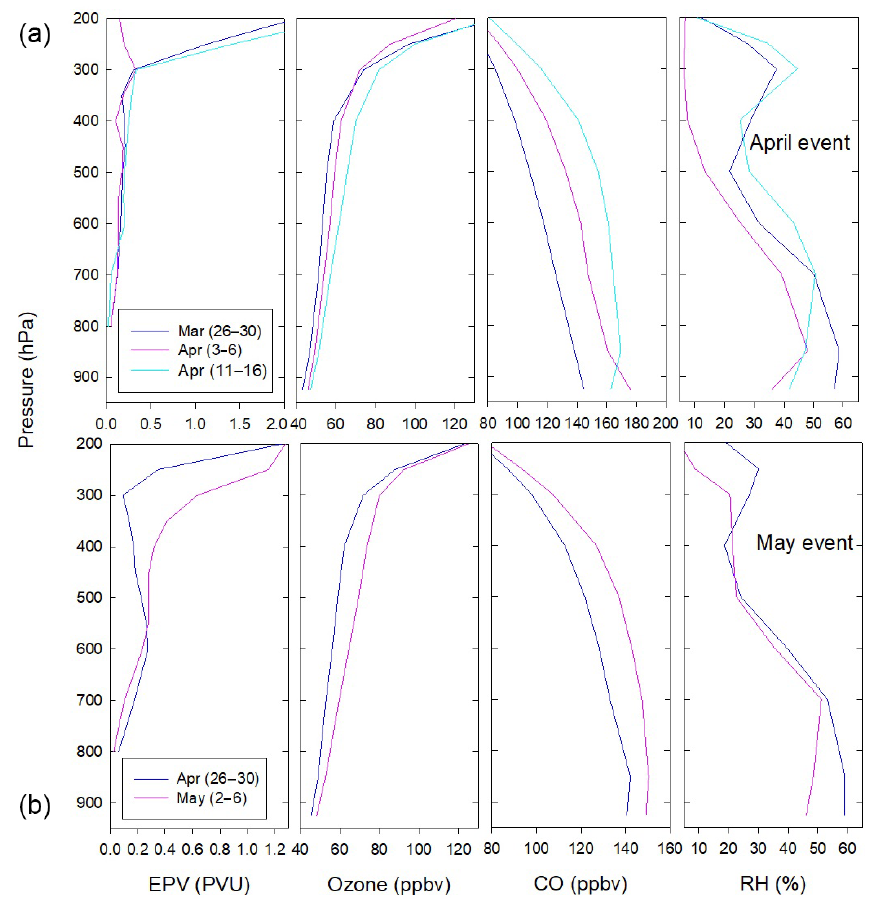
Figure 18. Vertical profiles of EPV, ozone, CO and RH during April (a) and May (b) biomass burning